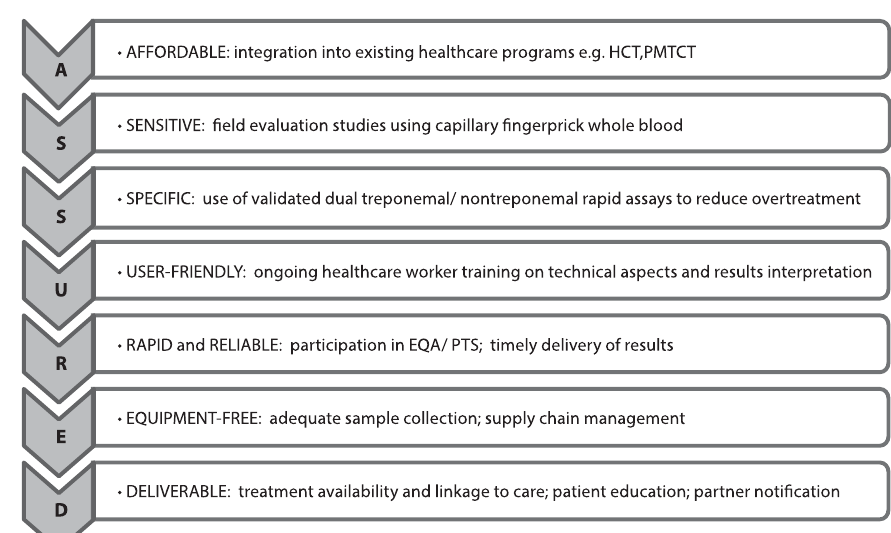
Figure 1: Programmatic requirements for the ful fi lment of WHO ASSURED criteria for a syphilis